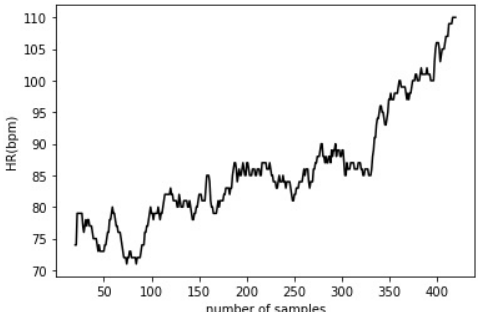
Figure 1. Heart rate variation (in beats per minute—bpm) of a healthy female subject during an incremental exercise (for more details see Appendix A.4).